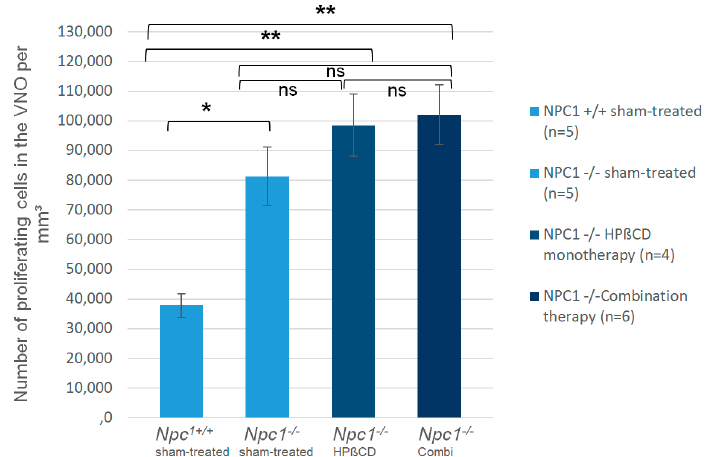
Figure 4. BrdU(+) cells within the vomeronasal epithelium of mutant and treated mice show a significant increase of proliferating cells in sham-treated Npc1 − / − mice and both, HP β CD-treated and combination treated animals in comparison to sham-treated Npc1 +/+ animals. * p < 0.05; ** p < 0.01; for p values see text.